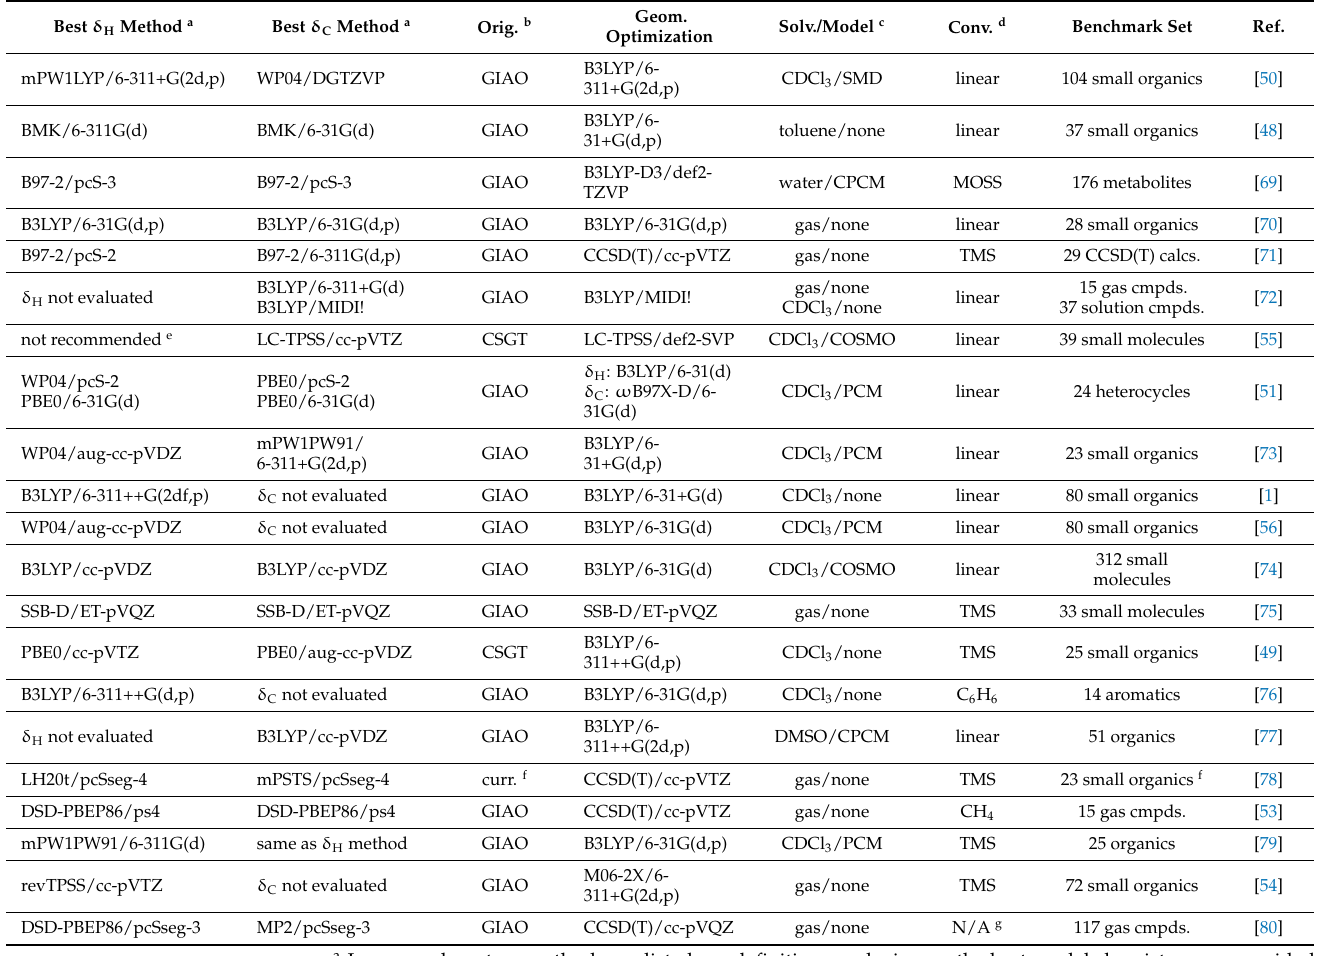
Table 1. Comparison of different benchmark studies for 1 H and 13 C NMR chemical shift